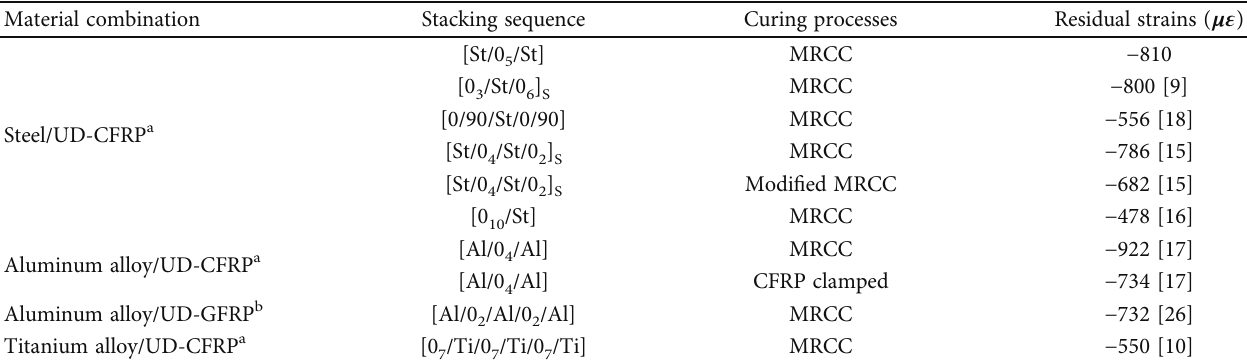
Table 4: Comparison of the longitudinal residual strains of the fi ber